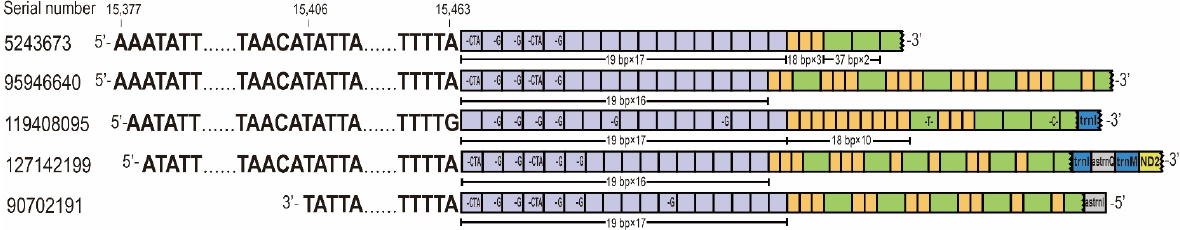
Figure 2. Five lncRNAs from CR contained tandem repeats in C. chinensis . Four transcripts ( above ) were encoded by J strand and one ( below ) by N strand. The purple, orange, and green squares represent each of the three tandem repeats and the bases within the squares represent polymorphic sites.